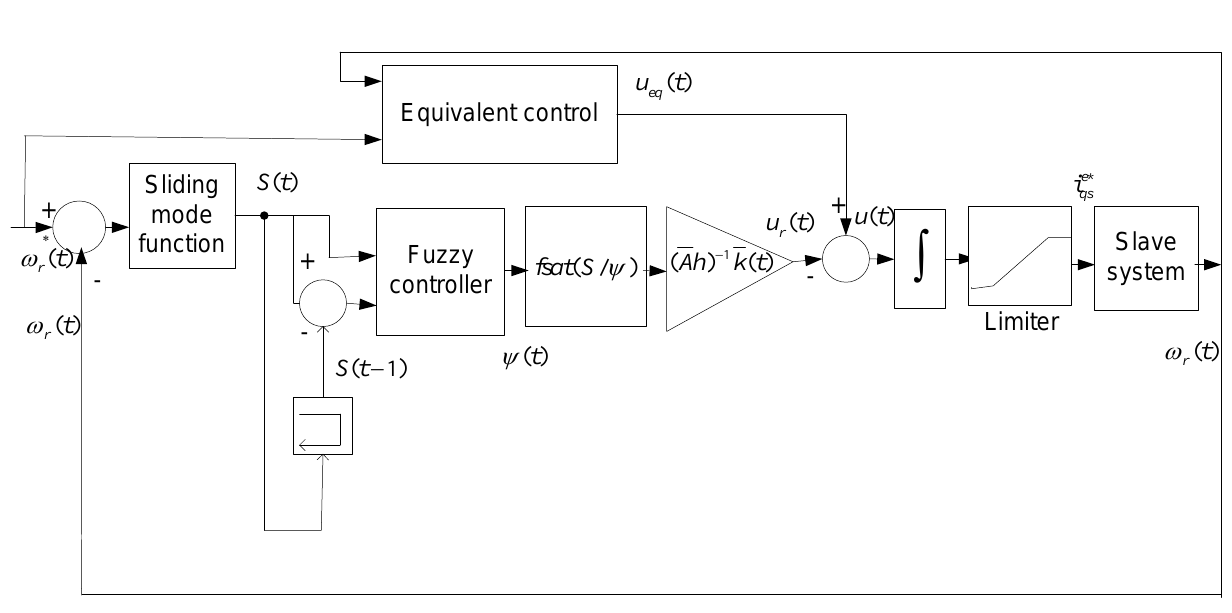
Figure 4. The control block diagram of the proposed NBLFC-based IM drive.